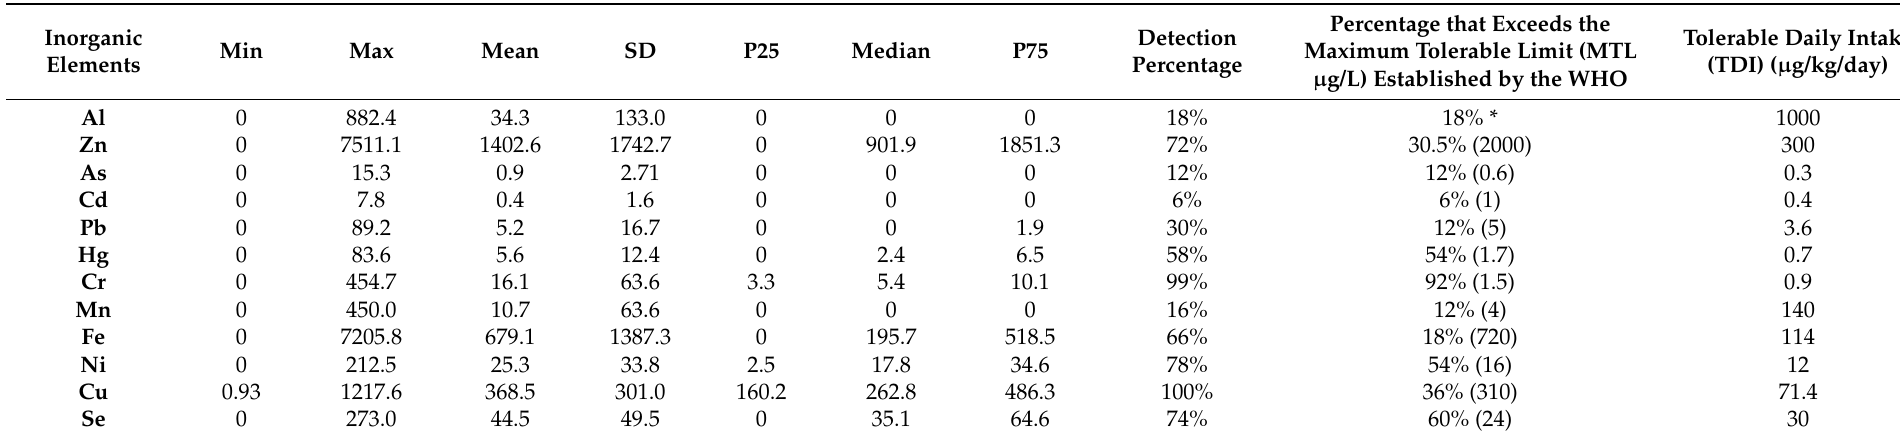
Table 3. Descriptive analysis of the levels of inorganic elements ( µ g/L) and percentage that exceeds the MTL established by the